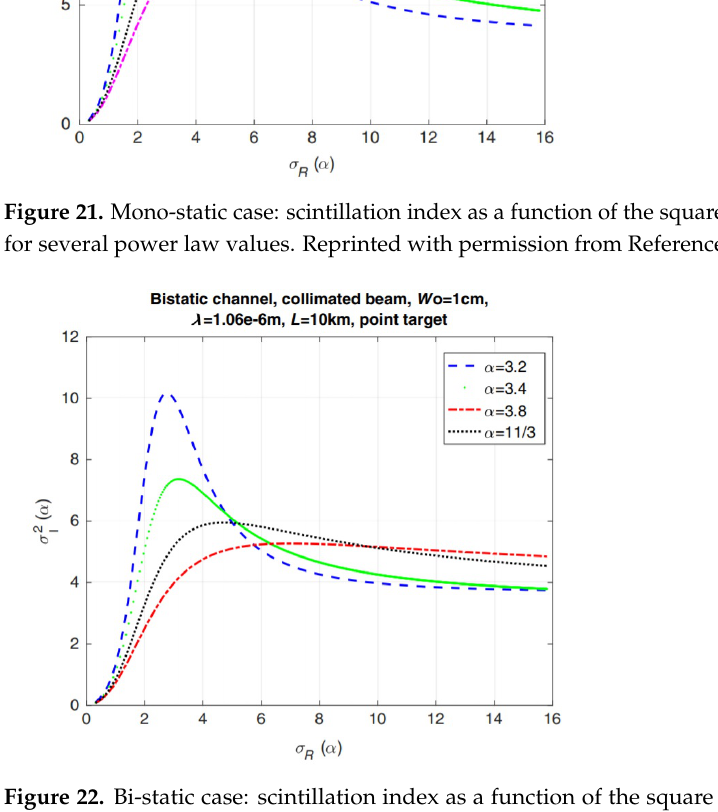
Figure 22. Bi-static case: scintillation index as a function of the square root of the Rytov variance for several power law values. Reprinted with permission from Reference